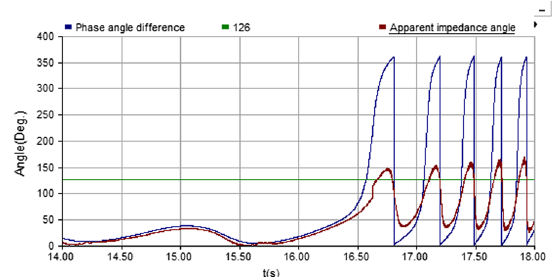
Fig. 6 Apparent impedance angle trajectory after